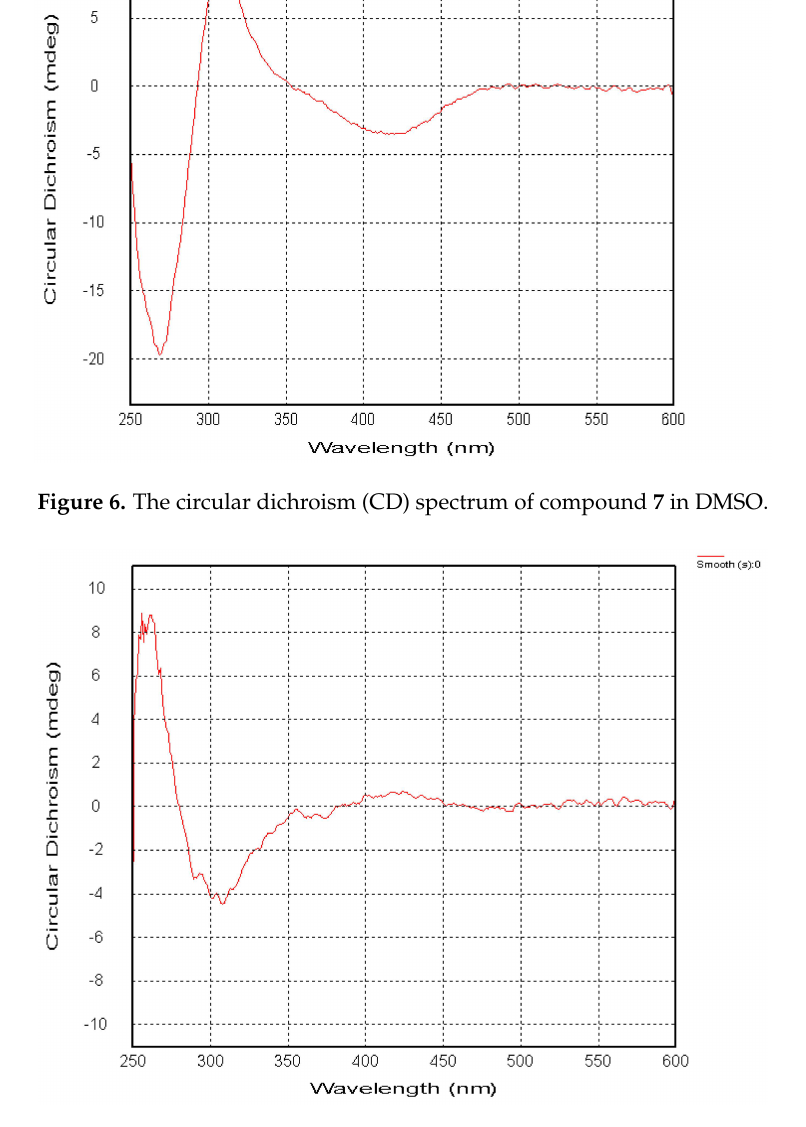
Figure 7. The circular dichroism (CD) spectrum of compound 7 with Mo 2 OAc 4 in